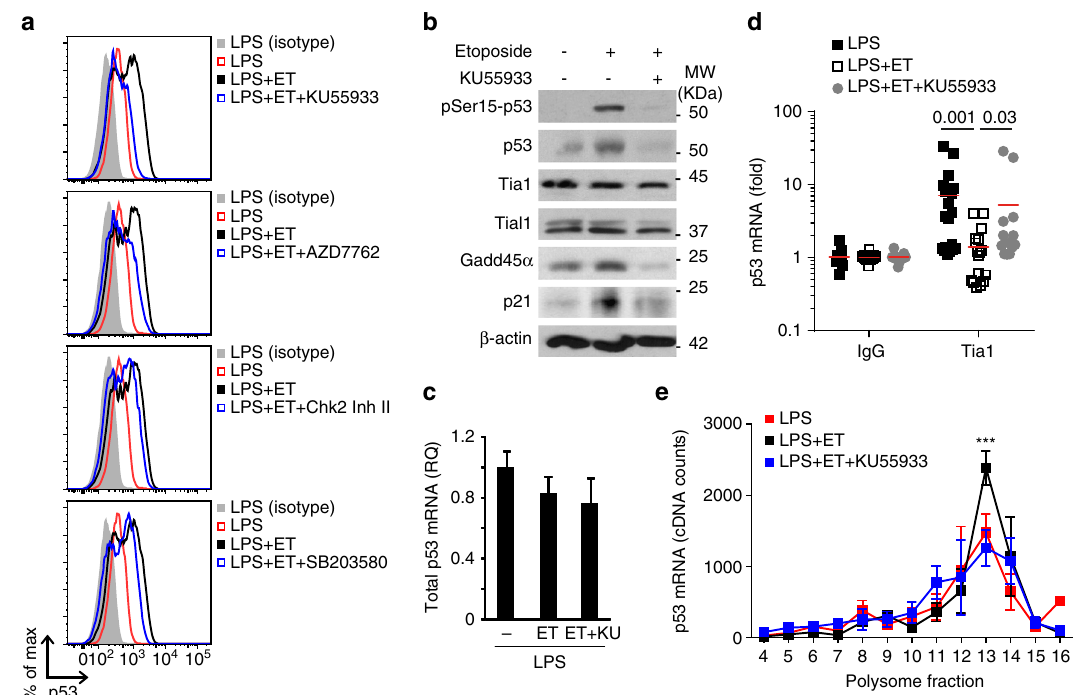
Fig. 9 ATM kinase inhibition prevents Tia1 dissociation and p53 mRNA translation after DNA damage induction. a Flow cytometry analysis of p53 protein expression in B cells activated with LPS for 48 h and treated with etoposide (20 μ M) for the last 4 h. ATM inhibitor KU55933, Chk1/2 inhibitor AZD7762, Chk2 inhibitor II and p38 inhibitor SB203580 (all at 10 μ M) were added to the cells 1 h before treatment with etoposide. b Immunoblot analysis of pSer15-p53, p53, Tia1, Tial1, Gadd45a, p21 and β -actin in LPS-activated B cells incubated with KU55933 prior treatment with etoposide. One of the two independent experiments performed is shown. c Total cellular P53 mRNA abundance measured by RT-qPCR. Data are shown as mean + s.e.m. d Tia1 protein: p53 mRNA co-immunoprecipitation in LPS-activated B cells treated with etoposide in the presence of the ATM inhibitor KU55933. An IgG isotype antibody was used as negative control in these RIP assays. Data are from six independent experiments. 2 – 3 technical replicates were performed in each experiment. Mann – Whitney test was performed for statistical analysis and P values are shown. e Polysome pro fi le of p53 from PolyRibo-3 ′ RNA-seq experiments performed in LPS-activated B cells incubated or not with the KU55933 inhibitor prior treatment with etoposide. Data are shown as mean + s.e.m. ( n = 4, post hoc pairwise t -test, *** P < 0.001 for both comparisons: LPS vs. LPS + etoposide (LPS + ET) and LPS + Etoposide vs. LPS